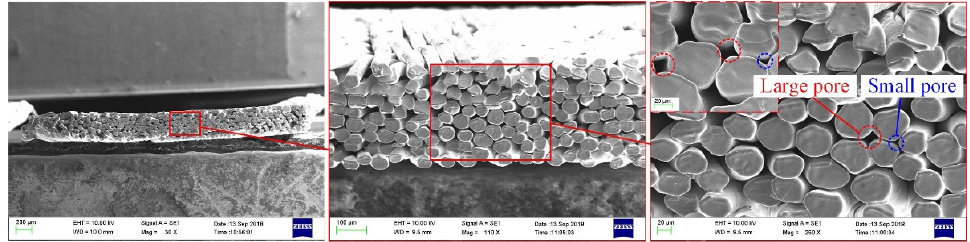
Figure 8. SEM images of composite woven mesh wick [18].